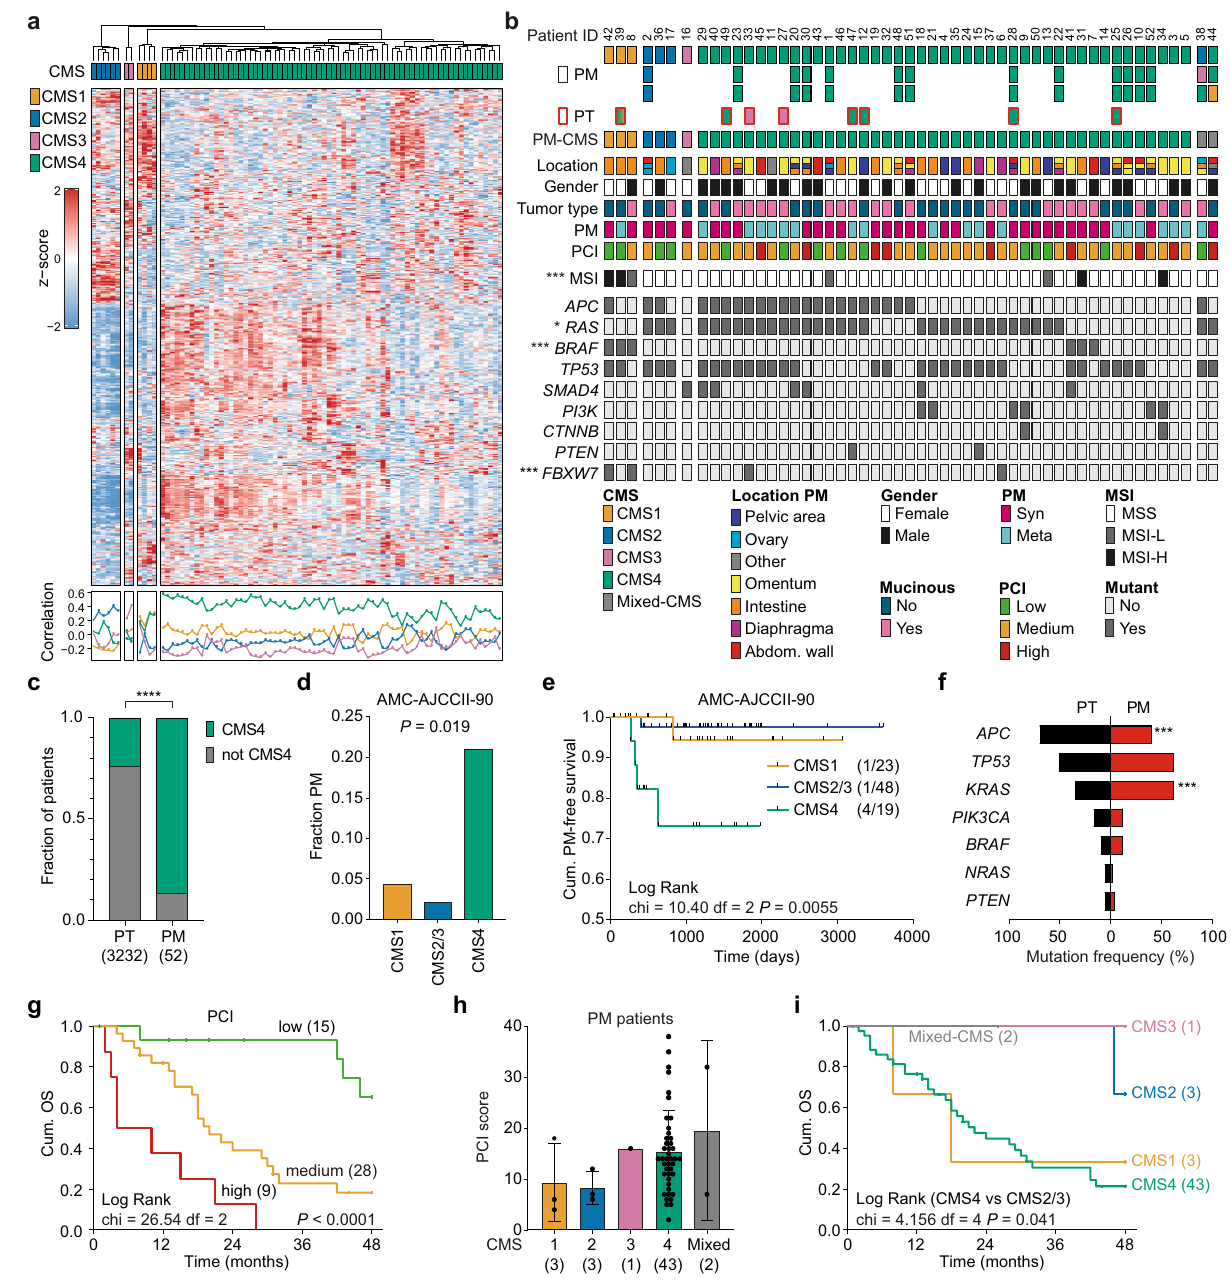
Fig. 1 | Molecular characterization of peritoneal metastasis tissue. a CMS clas- si fi cation of 82 fresh frozen peritoneal metastasis samples (CMSclassi fi er - Single Sample Prediction (SSP)). Samples are clustered by nearest CMS classi fi cation, indicated by the colors on top. Heatmap showing the expression of the top 500 most differentially expressed genes within the peritoneal metastasis group. Cor- relationofsampleswiththeCMSsubtypesisdepictedbelowtheheatmap,colorsof lines correspond with CMS subtype. b Schematic overview of 90 CRC-PM patient samples (52 patients). Squares represent individual tissue samples, colors indicate predictedCMSsubtype.Metastasissamples(PM, n =82,blackoutline)andprimary tumor tissue (PT, n =8, red outline). Location of PM, gender, primary tumor type, synchronous or metachronous development of peritoneal metastasis and PCI scores are depicted. MSI status and drivers gene mutations were derived from 1 sample per patient. Asterisks indicate signi fi cant differences between CMS sub- types (two-sided Chi-square, MSI *** P =0.0071; RAS * P =0.043; BRAF *** P =5.89E-